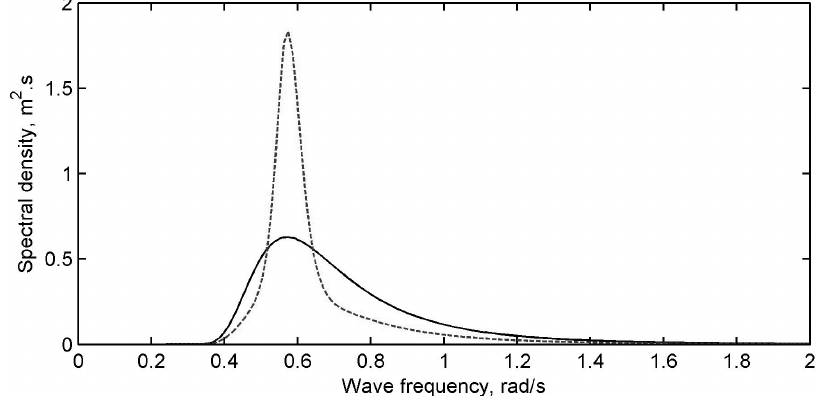
Figure 9. Jonswap wave spectrum of a sea-state with T bandwidth (solid) narrow bandwidth